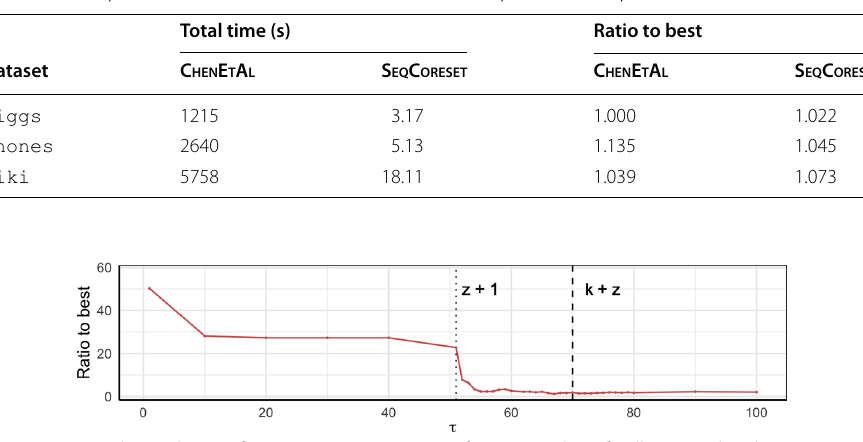
Table 2 Comparison of S eq C oreSet and C hen e t a l on a sample of 10,000 points from each dataset